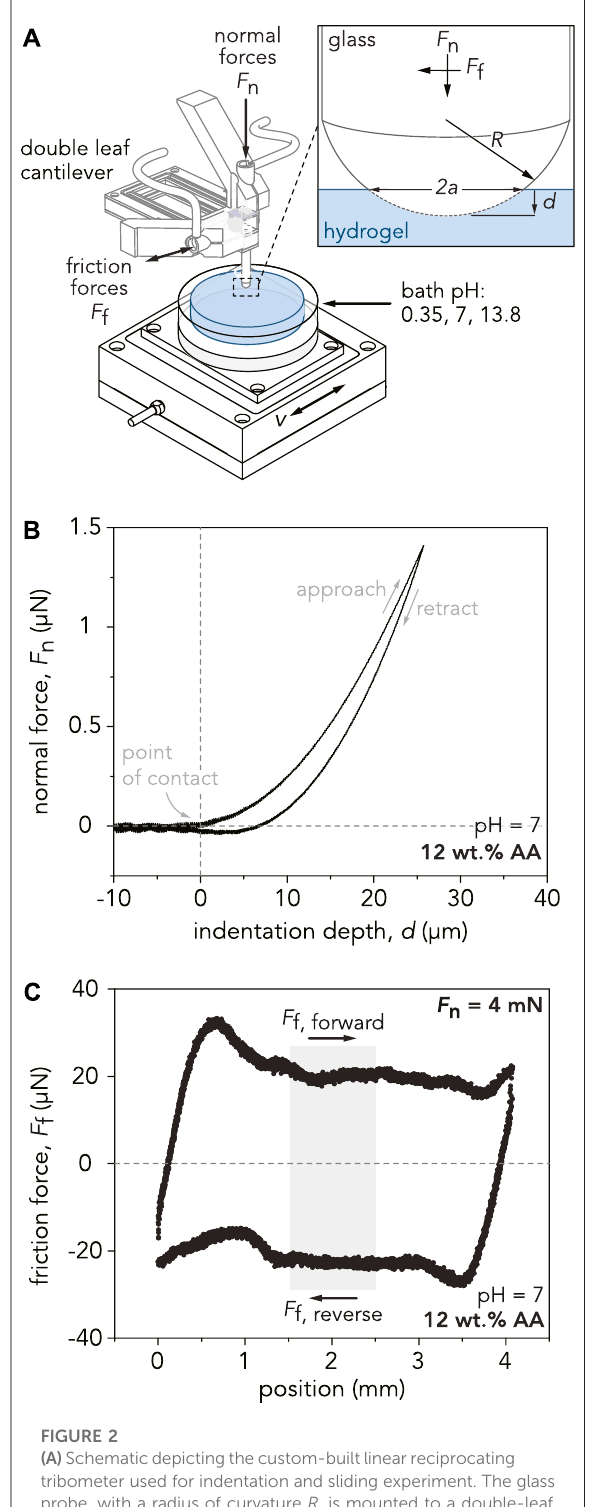
FIGURE 2 (A) Schematicdepictingthecustom-builtlinearreciprocating tribometer used for indentation and sliding experiment. The glass probe, with a radius of curvature R , is mounted to a double-leaf cantilever, which de fl ects in response to indentation and sliding. Capacitance probes measure the normal and tangential displacements of the cantilever, converting them into normal and friction forces. For indentation experiments, a de fi ned normal